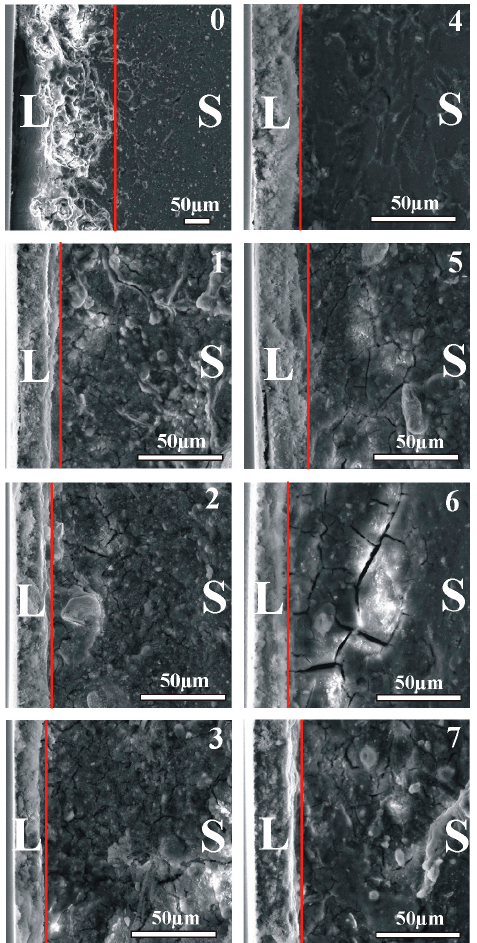
Figure 4. Cross-section view of the obtained hydrothermally treated hydroxyapatite surface layers (L) separated by a red line from the substrate (S) material marked in accordance to sample composition. ( 0 ): Mg pure—Reference sample; ( 1 ): Mg4Y5.5Dy0.5Zr; ( 2 ): Mg4Y5.5Dy0.5Zr + 5%BG; ( 3 ): Mg4Y5.5Dy0.5Zr + 5%BG + 1%Ag; ( 4 ): Mg1Zn1Mn0.3Zr; ( 5 ): Mg1Zn1Mn0.3Zr + 5%HA; ( 6 ):